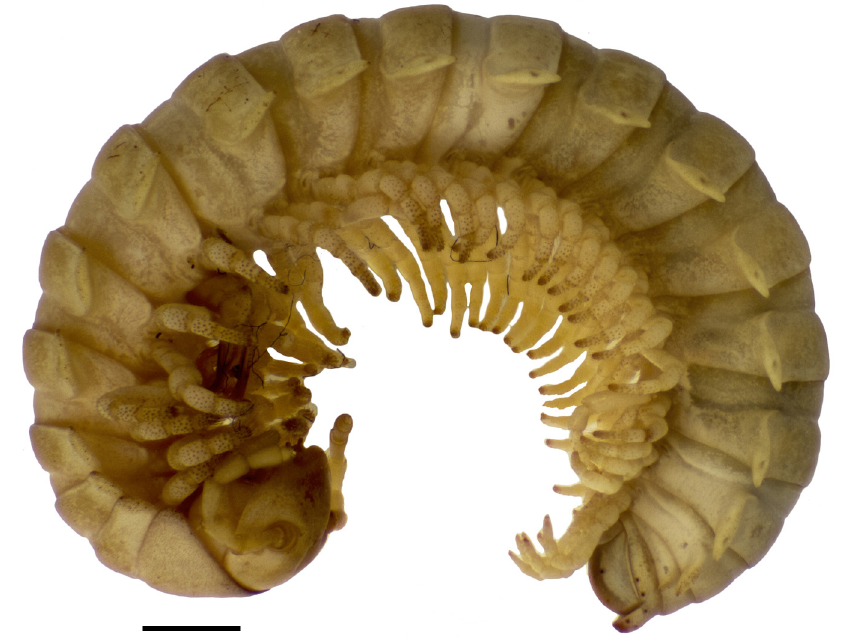
Fig. 1. Agrophogonus hamulifer Olsen & Enghoff sp. nov., paratype, ♂ (NHMD 621681), showing the typical gomphodesmid habitus. Scale bar: 2